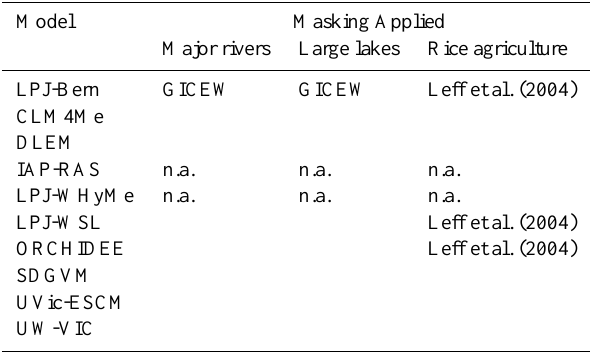
Table A1. Listing of masks used to correct simulated wetland ar- eas for non-natural wetland waterbodies per model. GICEW is the global land, ice and water mask from Hurtt et al.